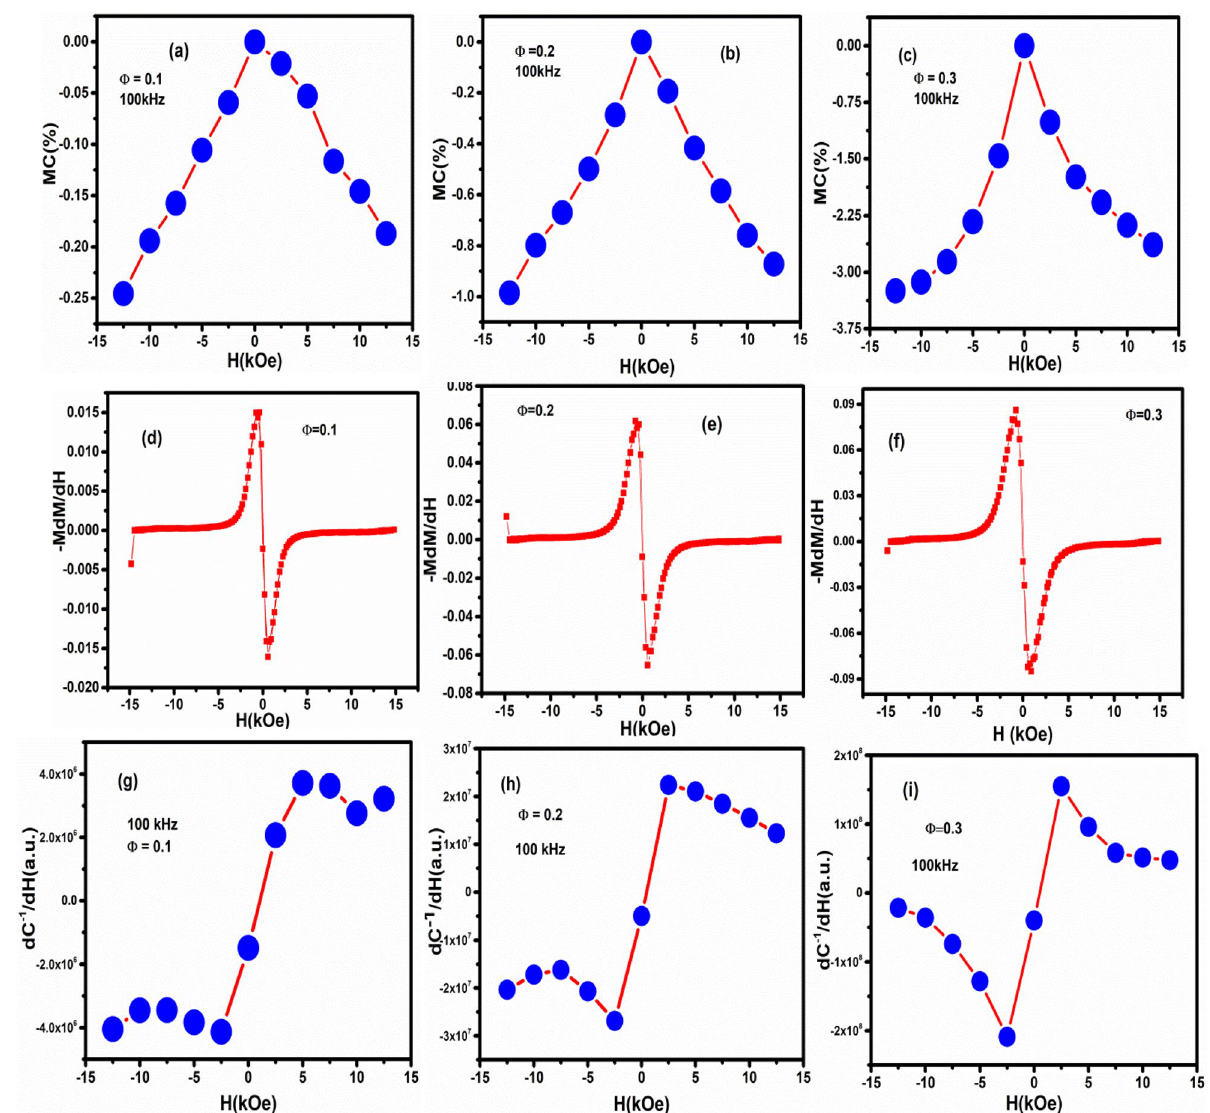
Figure 6. ( a – c ) Variation of MC% in both +Ve and –Ve applied magnetic fields for Φ = 0.1, 0.2, 0.3 of (1 − Φ) PbFe 0.5 Nb 0.5 O 3 -Φ Co 0.6 Zn 0.4 Fe 1.7 Mn 0.3 O 4 respectively at 100 kHz. ( d – f ) variation of –M × (dM/dH) with magnetic fields for Φ = 0.1, 0.2, 0.3 respectively. ( g – i ) variation of dC −1 /dH with magnetic fields for Φ = 0.1, 0.2, 0.3